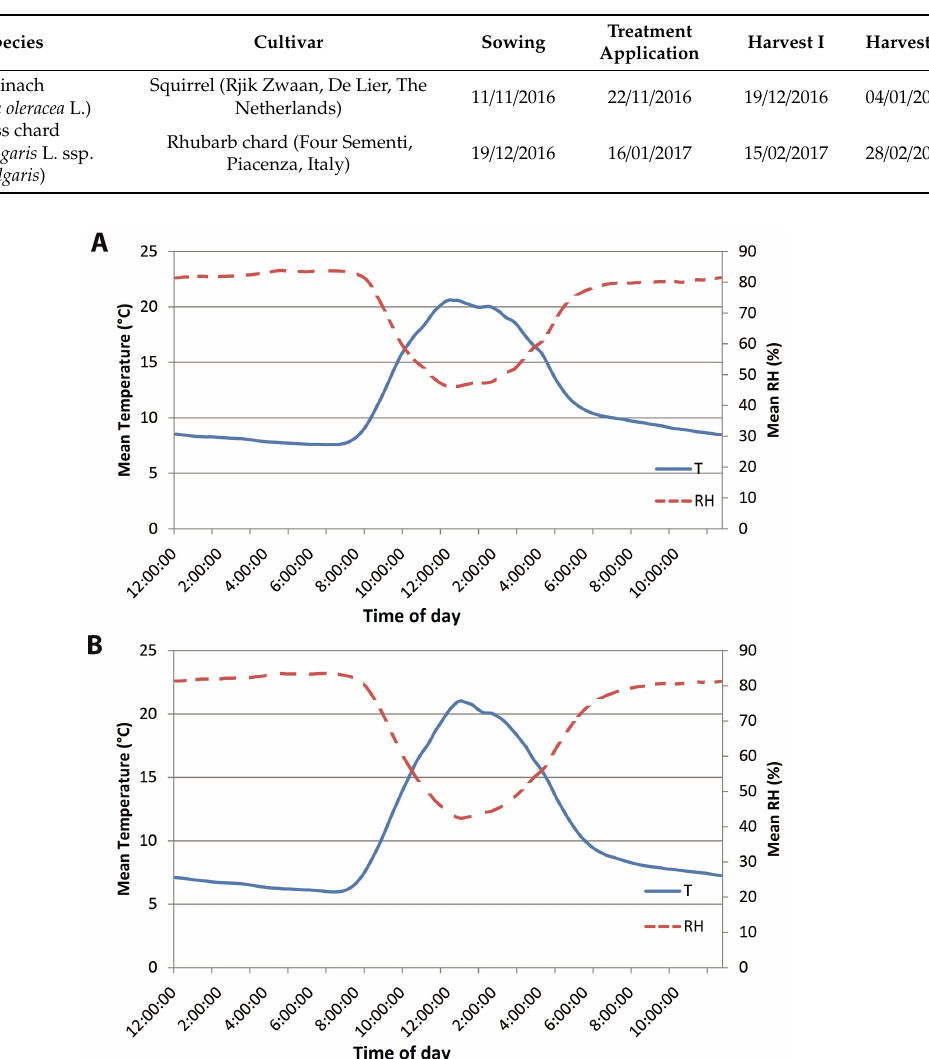
Figure 1. Average hourly temperature (T) and relative air humidity (RH) within the greenhouse during ( A ) spinach (11 Nov 2016 to 4 Jan 2017) and ( B ) Swiss chard (19 Dec 2016 to 28 Feb 2017) cultivation cycle.